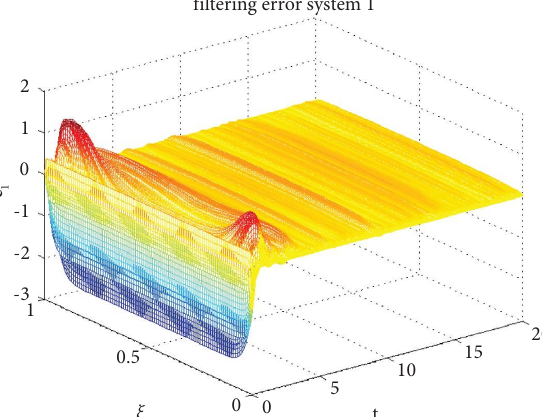
Figure 3: Filter error system development for flter 1.